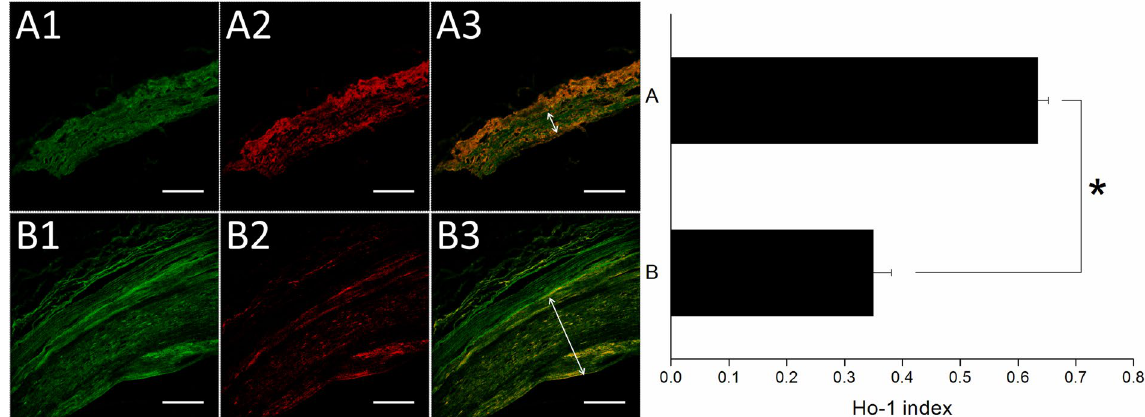
Figure 11. Immunofluorescence of Ho-1 on stented arteries following 24 weeks. Ho-1 immunostaining (red) of group A ( A ) and group B ( B ) stented region and autofluorescence on tunica media (green) were also shown. Great expression of positive labeling with Ho-1 was detected on the rapamycin-eluting cable tie stented vessels. The double arrow illustrates tunica media. Group B showed that substantial neointimal hyperplasia (Scale bar = 150 μ m).